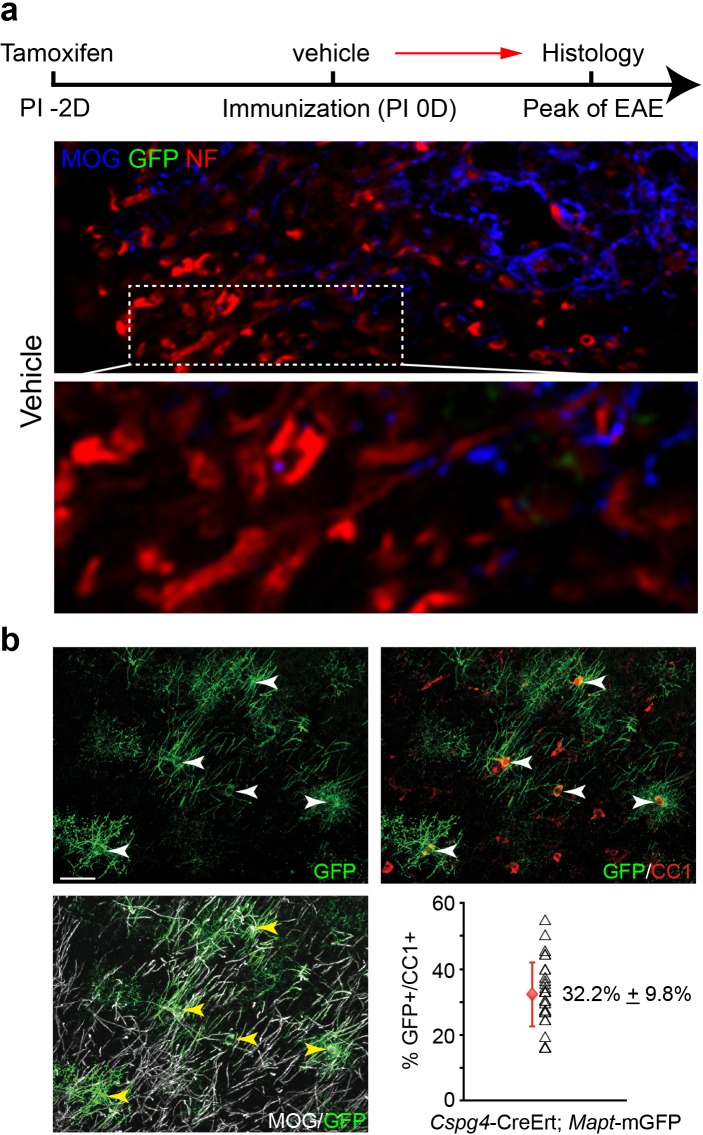
Oligodendroglial lineage-specific tracing of remyelination in EAE treated with vehicle.Cspg4-CreErt; Mapt-mGFP recombination is induced with a single dose of tamoxifen at two days prior to immunization. (a) MOG and NF immunostaining showing demyelinated axons without GFP positive myelin sheaths. (b) Recombination efficiency of the Cspg4-CreErt; Mapt-mGFP mice was examined in 14-day old mice by administration of tamoxifen at postnatal day 8. By examining cortical regions where myelination is sparse at postnatal day 14, we immunostained for GFP, CC1 (oligodendrocytes) and MOG (myelin) and quantified the percentage of GFP positive, CC1 positive oligodendrocytes. The mean recombination percentage is presented with an error bar that represents s.d (red). Three mice were used for quantification of recombination efficiency.